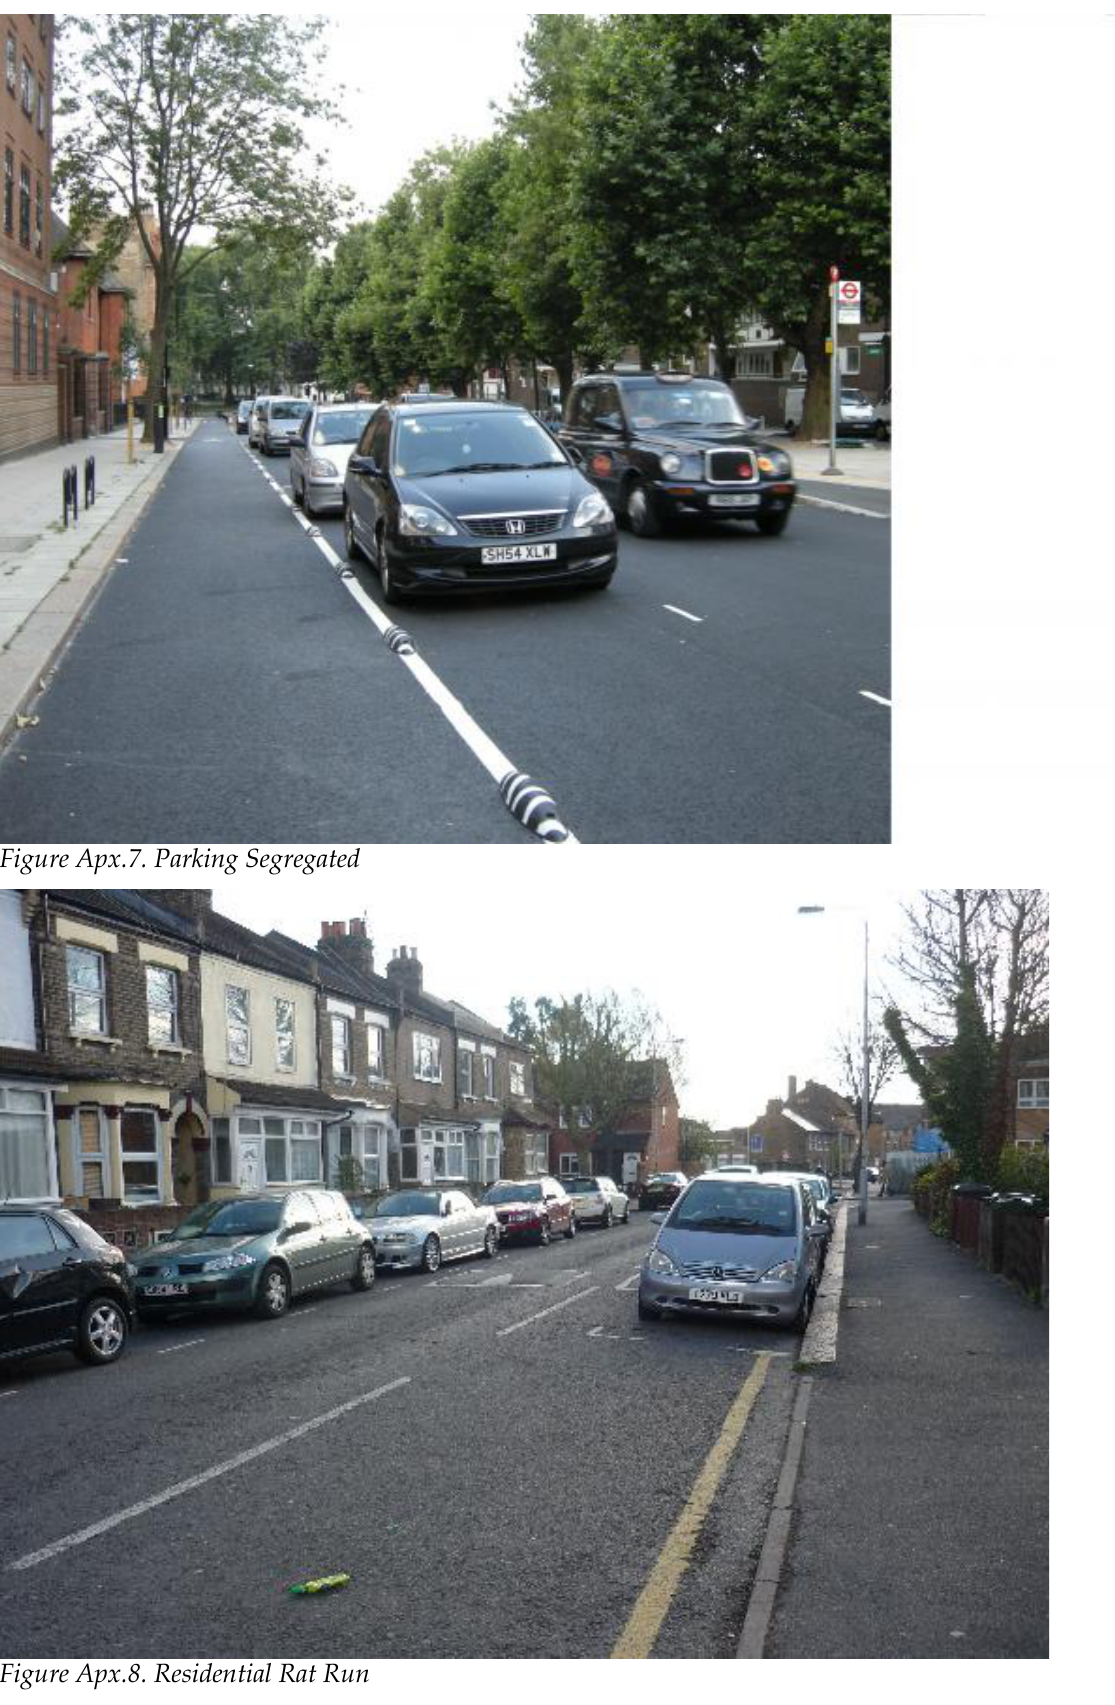
Figure Apx.8. Residential Rat